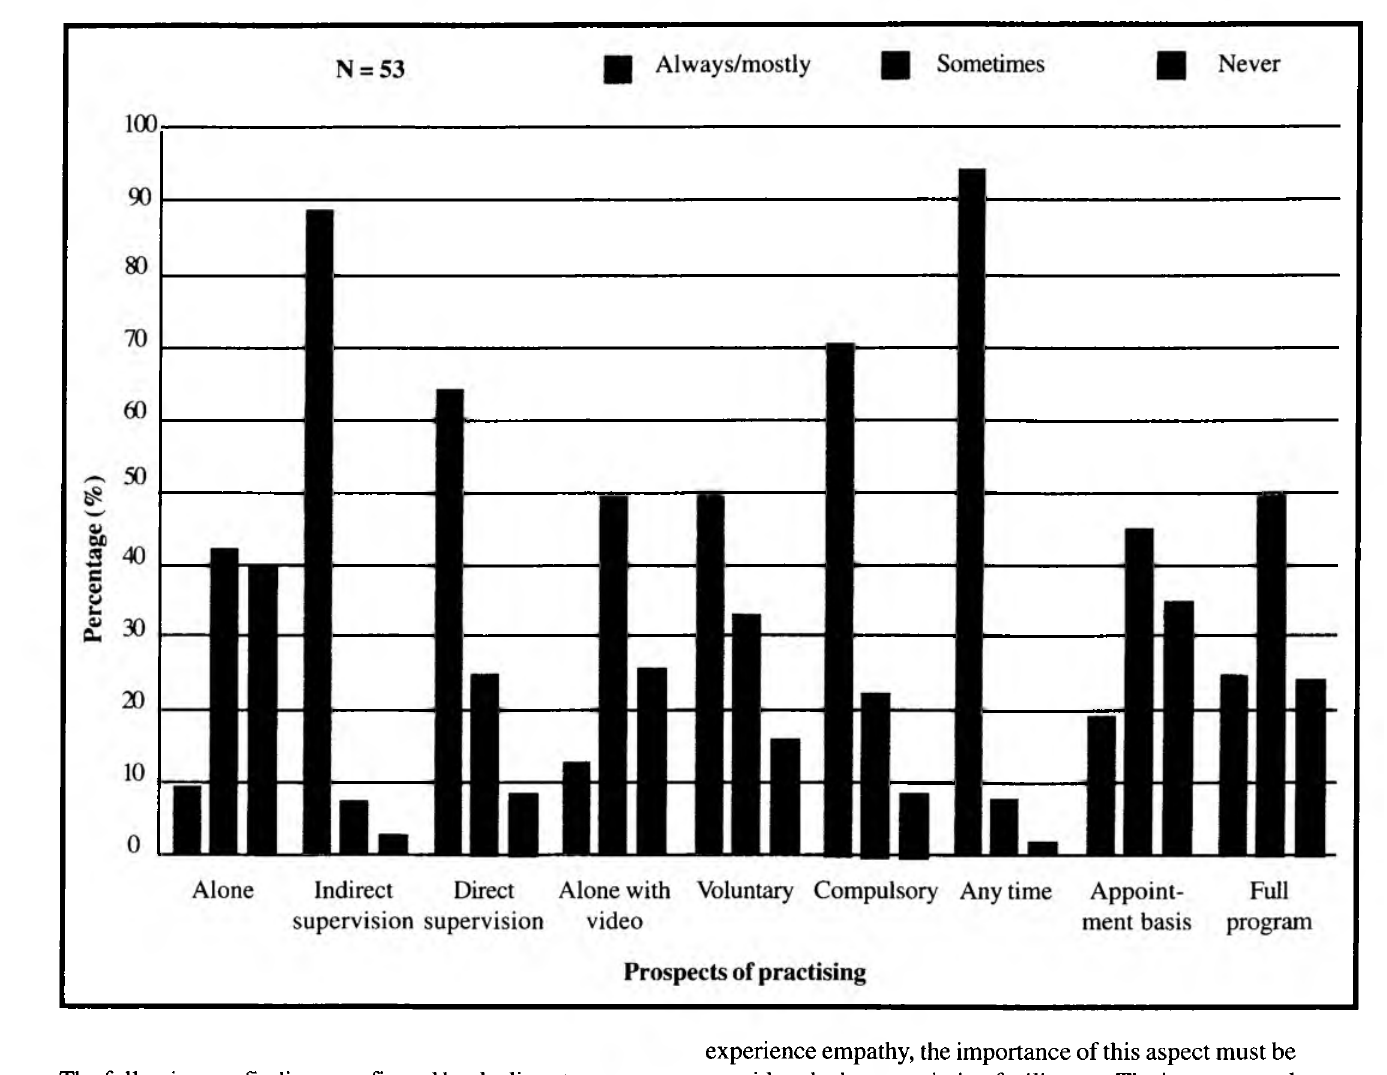
Figure 4: Prospects of practising during formal clinical teaching in simulation